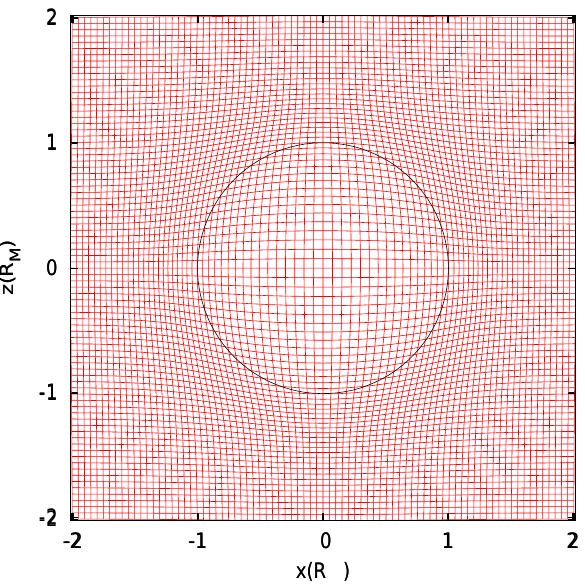
Fig. 4. Structure of the simulation grid used. A cross section through the box is shown with α = 0 . 21, β = 0 . 37 and γ = 7 . 07 (see text) consisting of 80 × 80 cells in the plane y = 0. This grid used for the actual simulation runs, gives a higher resolution near the Mar- tian surface (black circle) compared to the outer cells.